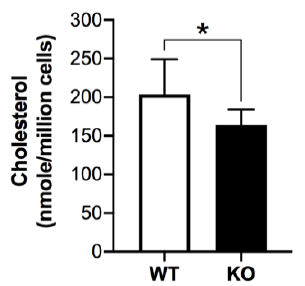
Figure 4. Decreased amounts of total cholesterol in Sertoli cells from 8-month-old Arsa KO mice as compared with Sertoli cells from age-matched WT mice. * denotes a significant difference ( p < 0.05) of the cholesterol amounts between the two samples. Results shown are from six replicate experiments.